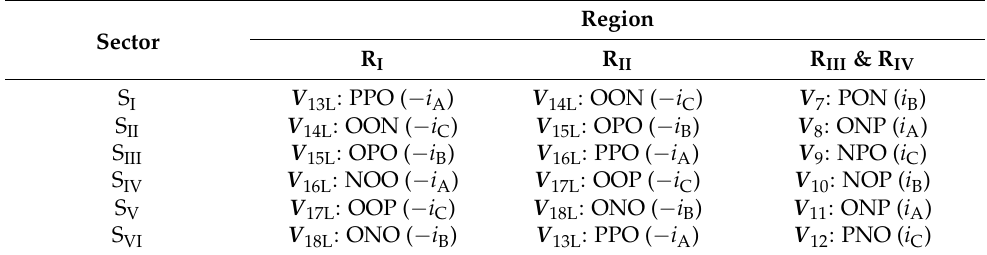
Table 4. Master vector in each region.